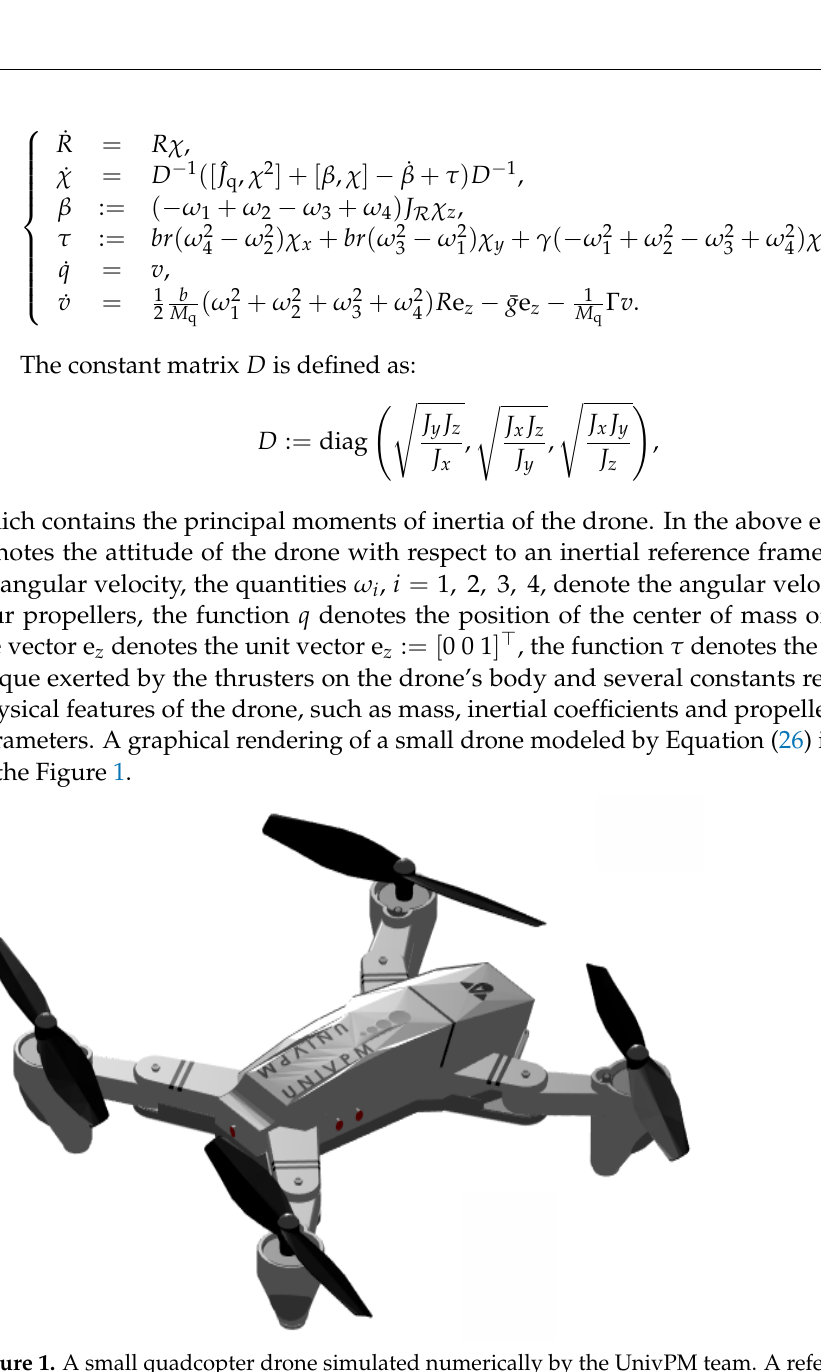
Figure 1. A small quadcopter drone simulated numerically by the UnivPM team. A reference system attached to the drone has its x - y axes parallel to the plane of the drone and the z axis normal to such a